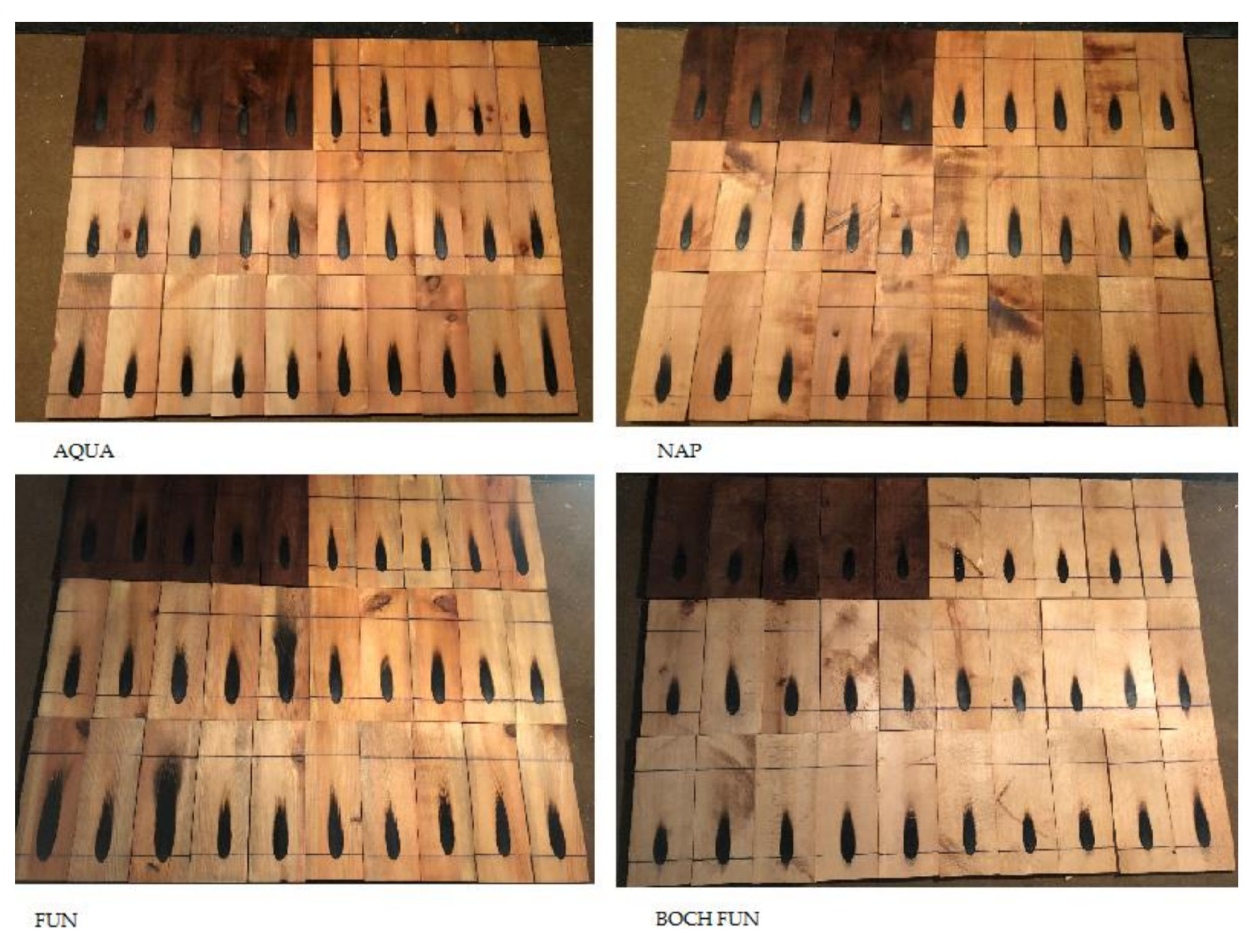
Figure 5. Presentation of wood samples after the experiment. The order of wood species is sorted from left to right as follows: 1 row—SM (spruce) and SMR (red spruce); 2 row—JAS (ash) and BOR (pine); 3 row—DUB (oak) and BUK